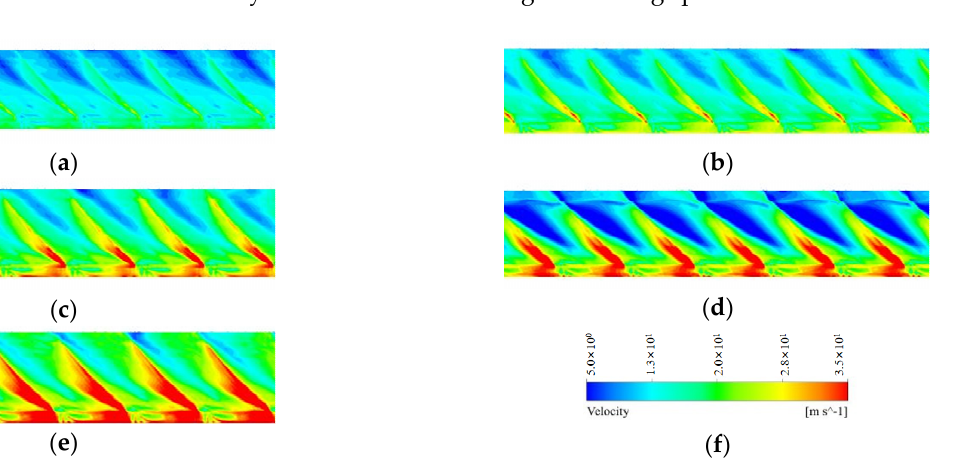
Figure 20. Velocity streamline diagram of the rotor blade tip at different rotating speeds (( a ) 2000rpm; ( b ) 2600 rpm; ( c ) 3200rpm; ( d ) 3600 rpm; ( e ) 4000 rpm; ( f ) legend).